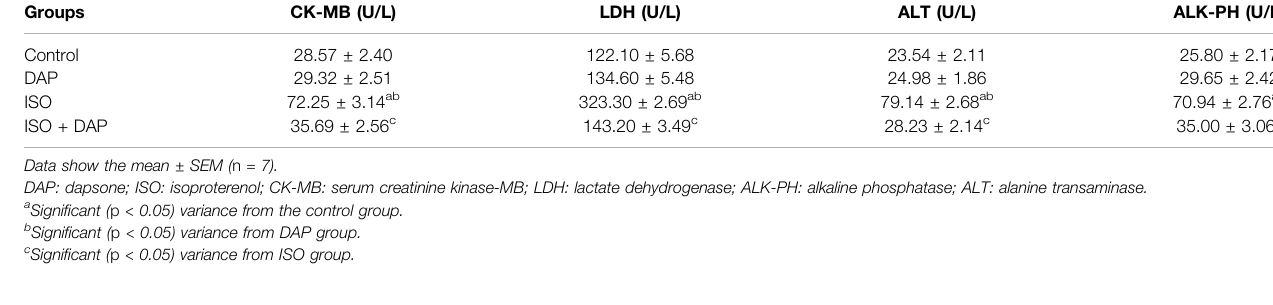
TABLE 2 | In fl uence of DAP on cardiac enzymes in MI in rats. Groups CK-MB (U/L)